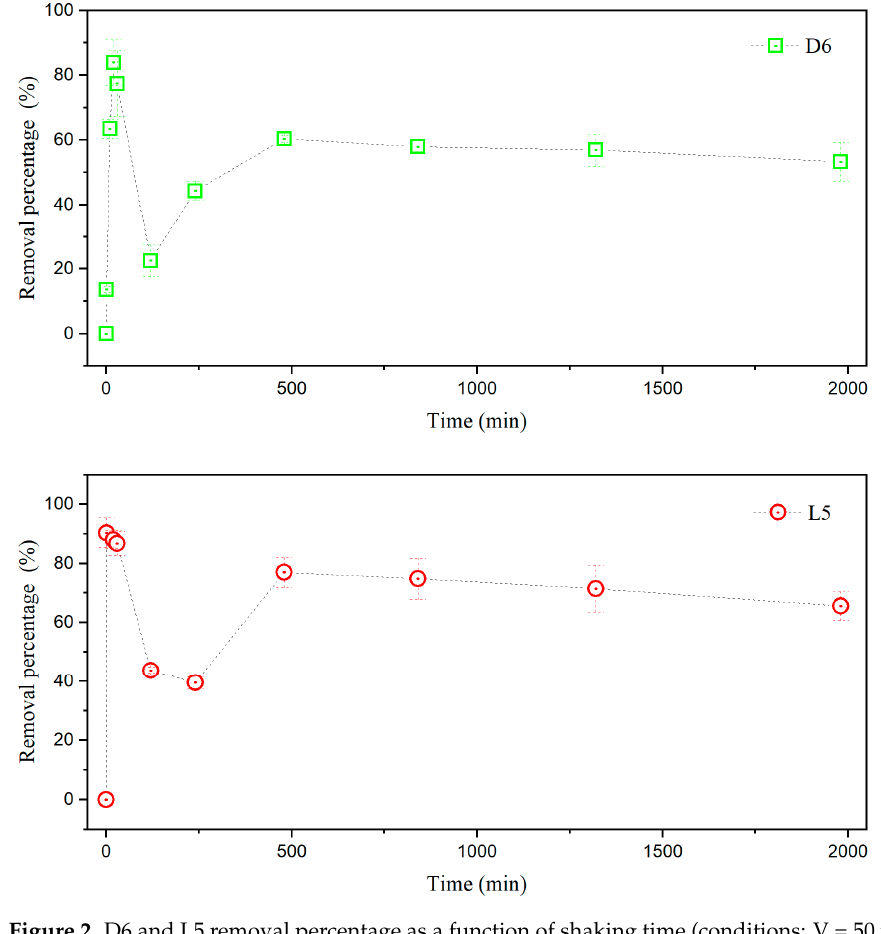
Figure 2. D6 and L5 removal percentage as a function of shaking time (conditions: V = 50 mL; L5 and D6 concentrations = 20 ppb; MSW dosage = 10 g; T = 298 K).